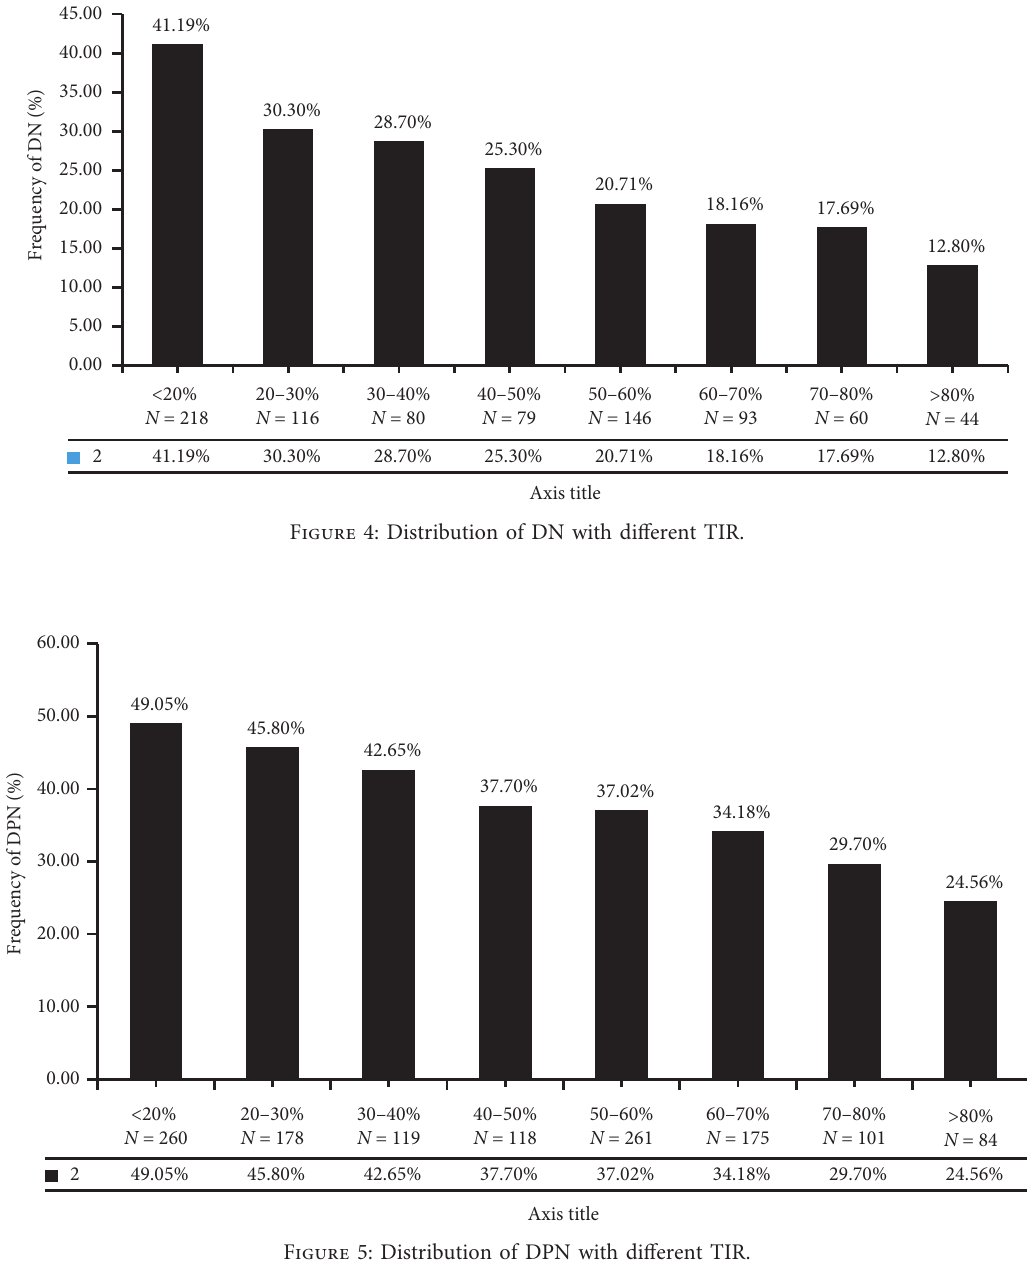
Figure 5: Distribution of DPN with different